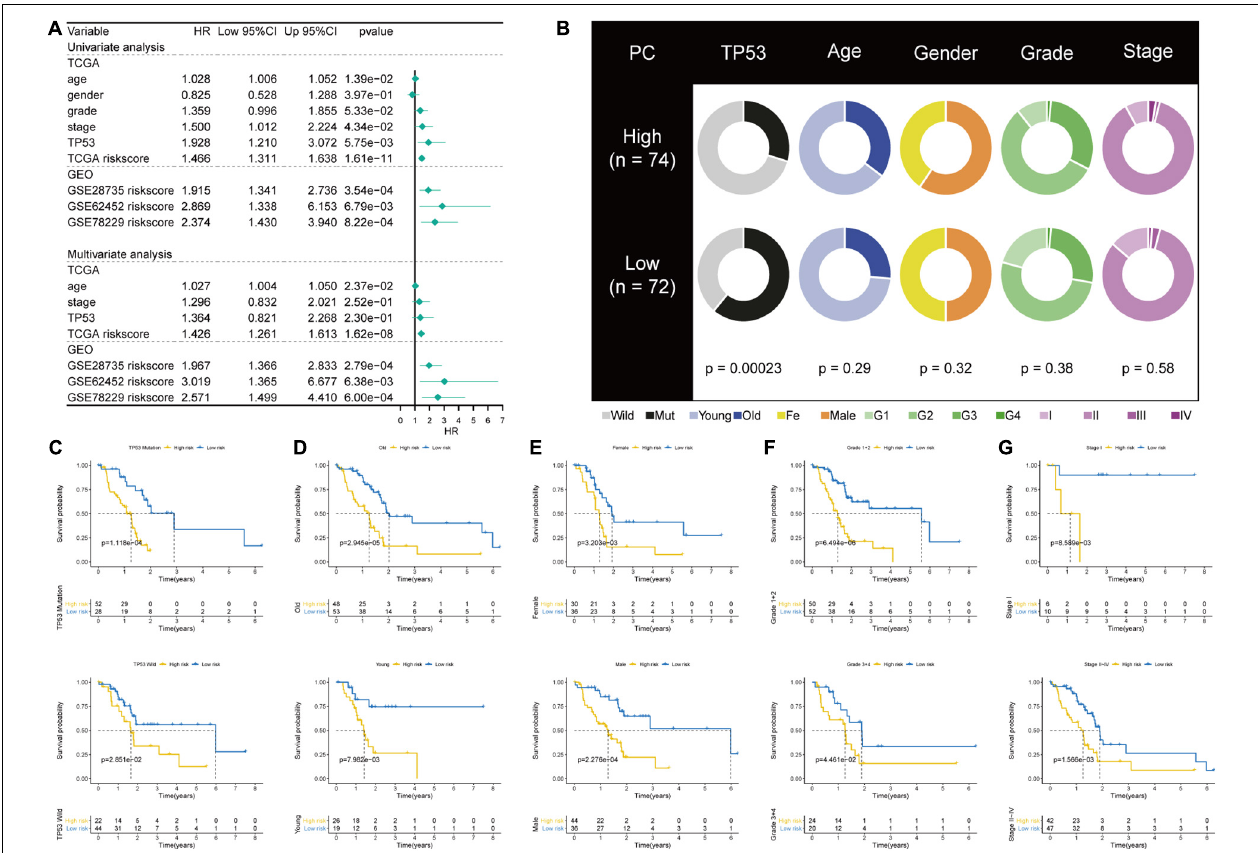
FIGURE 4 | Correlations with clinicopathological characteristics and prognostic independence of the TP53-associated signature. (A) Univariate and multivariate regression analyses of the TP53-associated signature and other clinicopathological factors. (B) Pie charts showing the chi-square test of clinicopathological factors in pancreatic cancer (PC) samples from The Cancer Genome Atlas (TCGA) cohort based on the TP53-associated signature. (C–G) Kaplan–Meier survival analysis of (C) TP53 mutation and wild-type subgroup, (D) age > 60 and age < 60 subgroup, (E) male and female subgroup, (F) grades 1 + 2 and 3 + 4 subgroup, (G) TNM stage I and II–IV